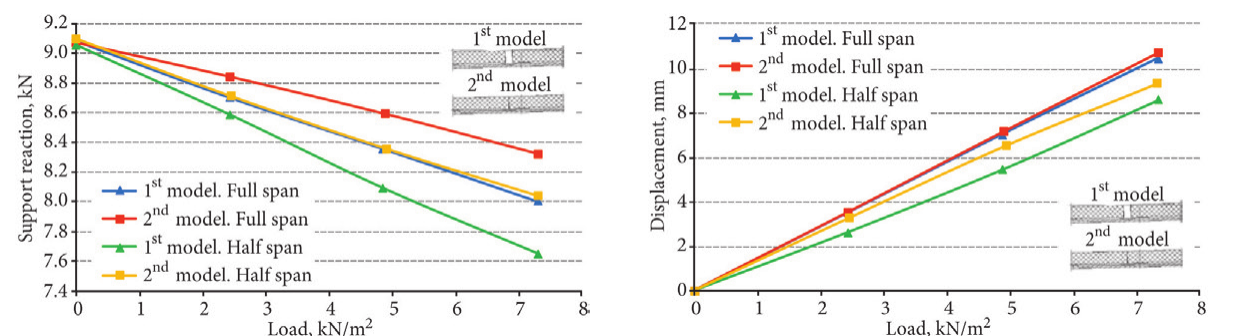
Fig. 8. Maximal displacements under different loading cases